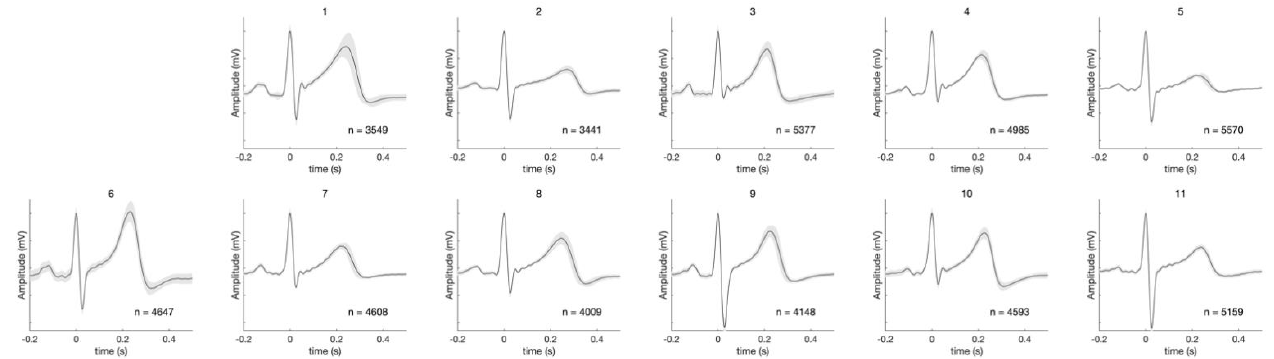
Figure 4. Synchronized average of ECG signals from 11 subjects. The shaded areas represent the standard deviation in the signals.